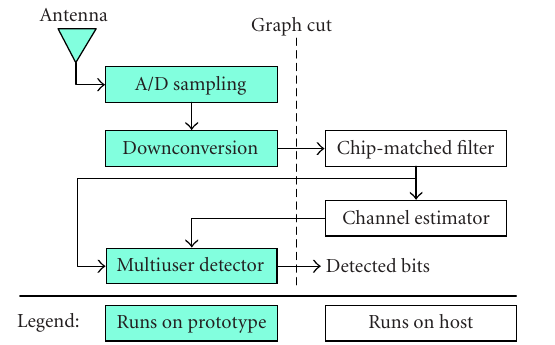
Figure 6: The directed graph of a CDMA baseband receiver after partitioning.